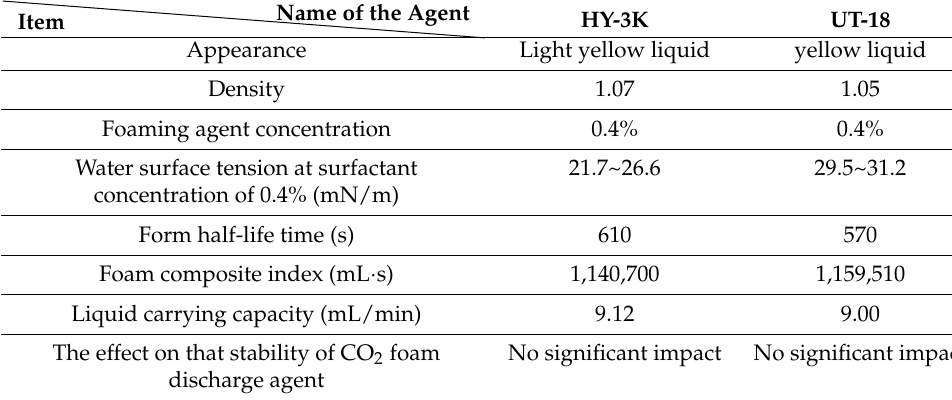
Table 4. Properties of the selected foaming